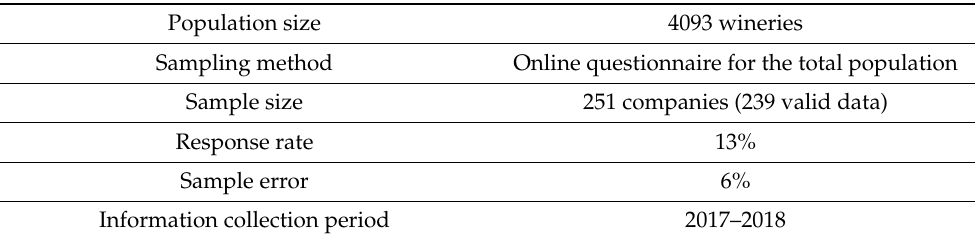
Table 1. Technical file of the survey carried